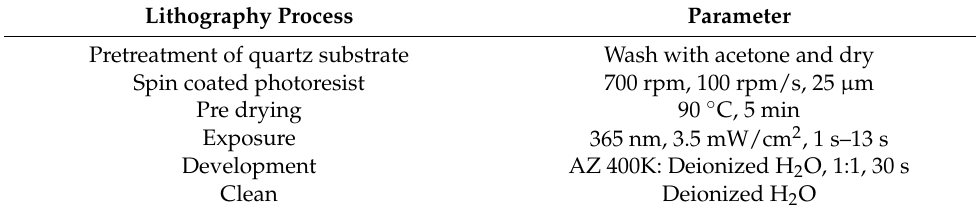
Table 1. Exposure process